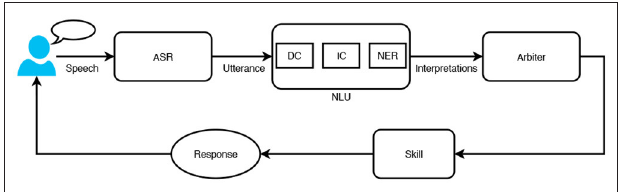
FIGURE 1 | A high-level overview of an intelligent personal assistant (IPA).